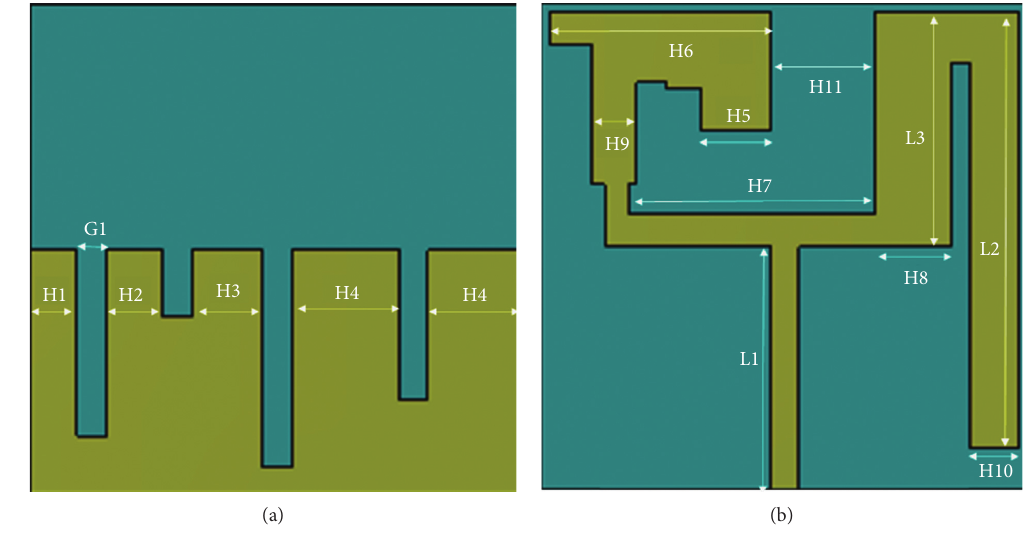
Figure 4: Proposed design geometry: (a) bottom and (b) top. Table 2: Dimensions of the proposed antenna.